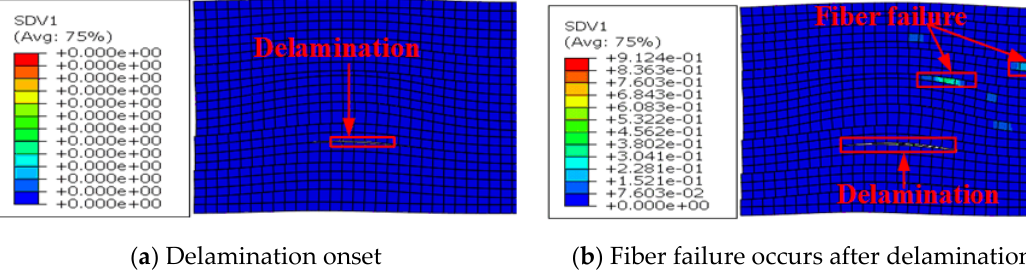
Figure 17. Elastoplastic model prediction of damage sequence for a laminate with wrinkle level 11.4°.